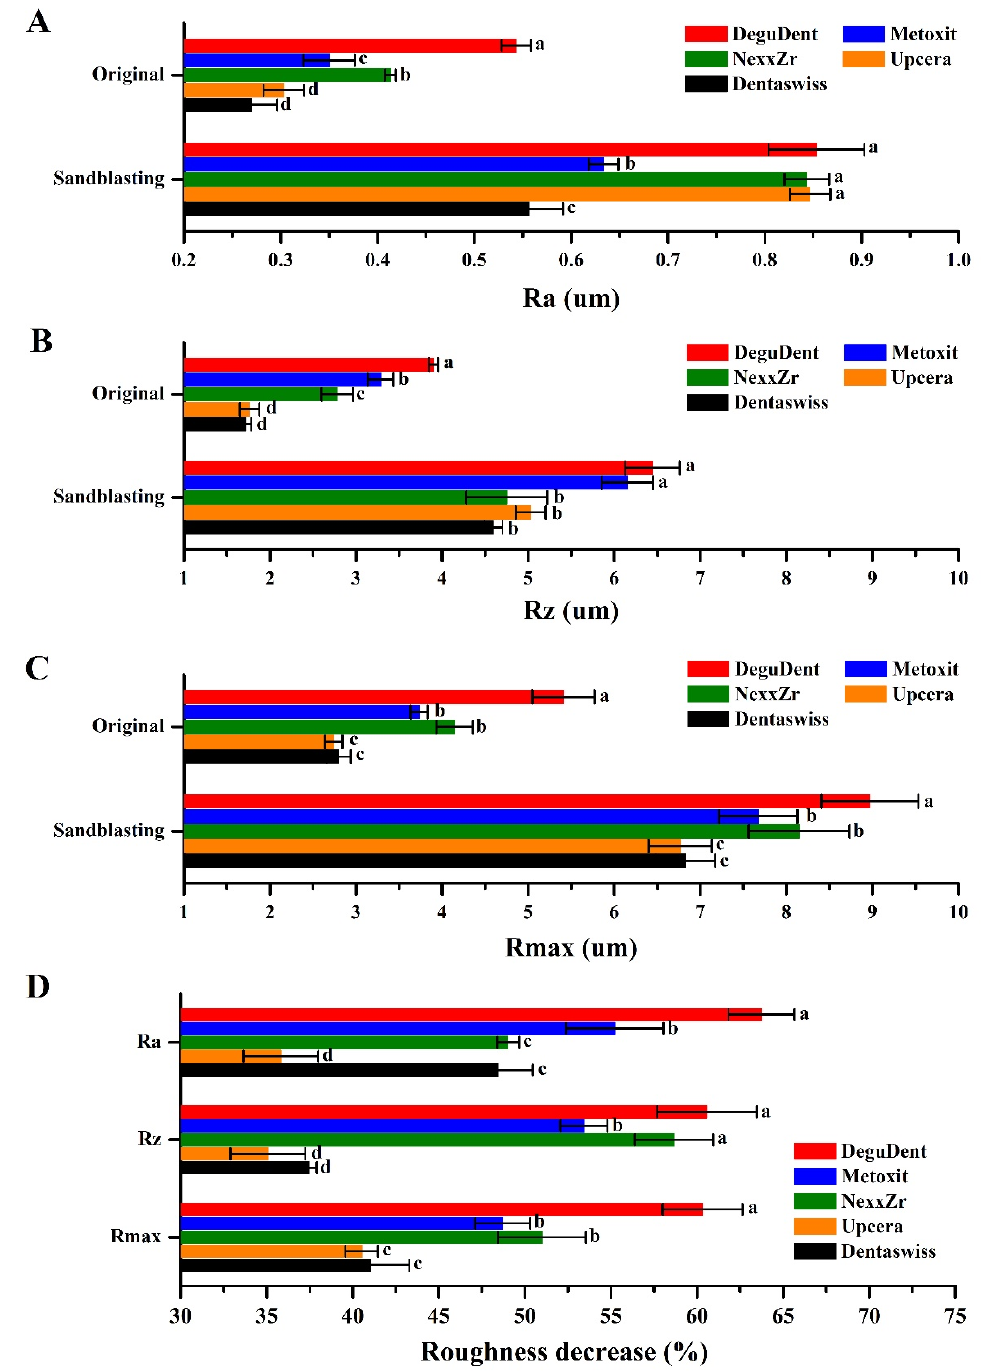
Figure 5. The surface roughness of different brands of zirconia samples ( A ) Ra, ( B ) Rz, ( C ) Rmax and ( D ) Cpmpare. Means with different letters were significantly different ( p < 0.05, mean ± SD, n = 4).